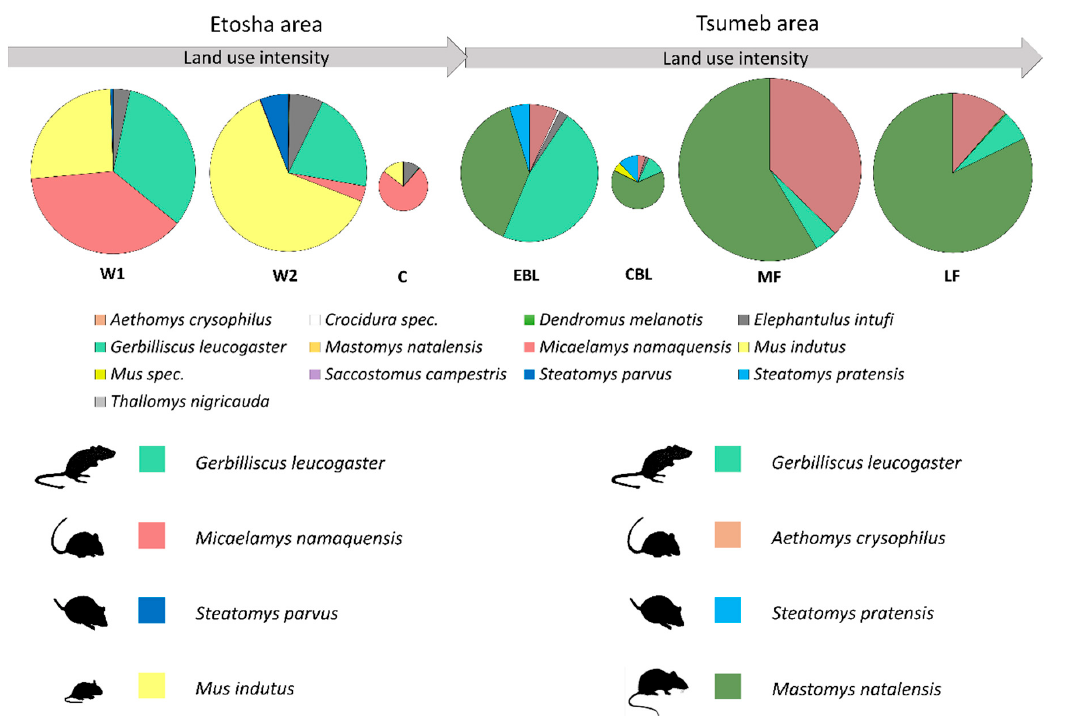
Figure 3. Species composition and capture frequency (RCI-captures / 100 trap nights) along two gradients of land use intensity in the two study areas. Size of pie charts relates to total RCI values. WF1 / WF2 = wildlife farmland 1000 m / 50 m distance from waterhole, C = cattle farm, EBL / CBL = cattle grazing on encroached / cleared bushland; MF / LF = maize / lucerne field. Species responding with changes in capture frequency of ≥ 50% between classes of land use intensity are shown below ( G. leucogaster